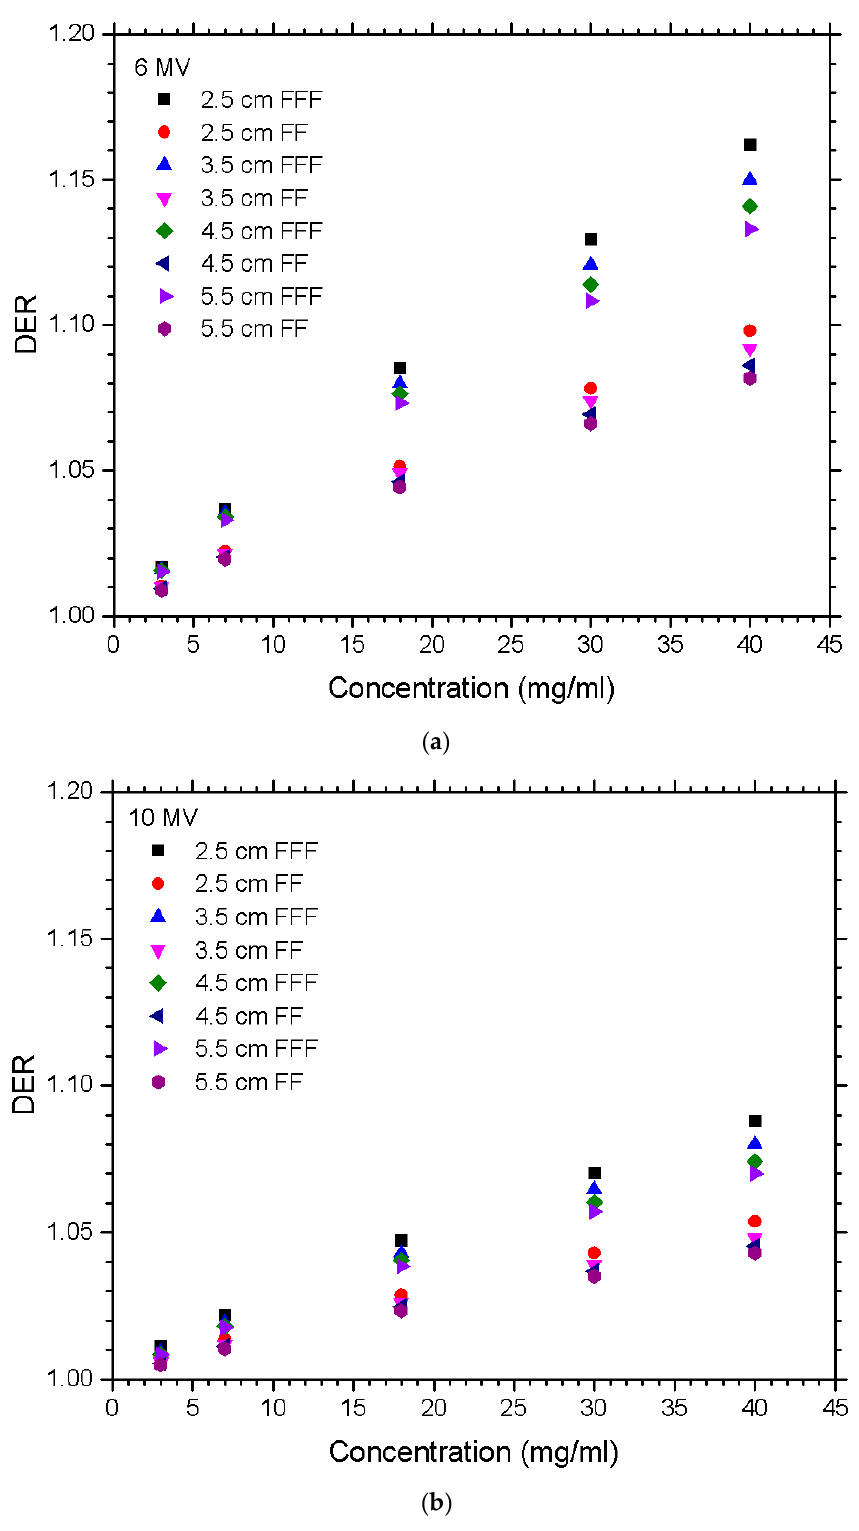
Figure 2. Relationships of the DER and nanoparticle concentration varying with different prostate sizes in the phantom using the ( a ) 6 MV and ( b ) 10 MV photon beams. Gold nanoparticles with concentrations equal to 3, 7, 18, 30, and 40 mg / ml were used. The DER was calculated as the ratio of the target dose with nanoparticle addition to the target dose without nanoparticle addition under the same simulation configuration.